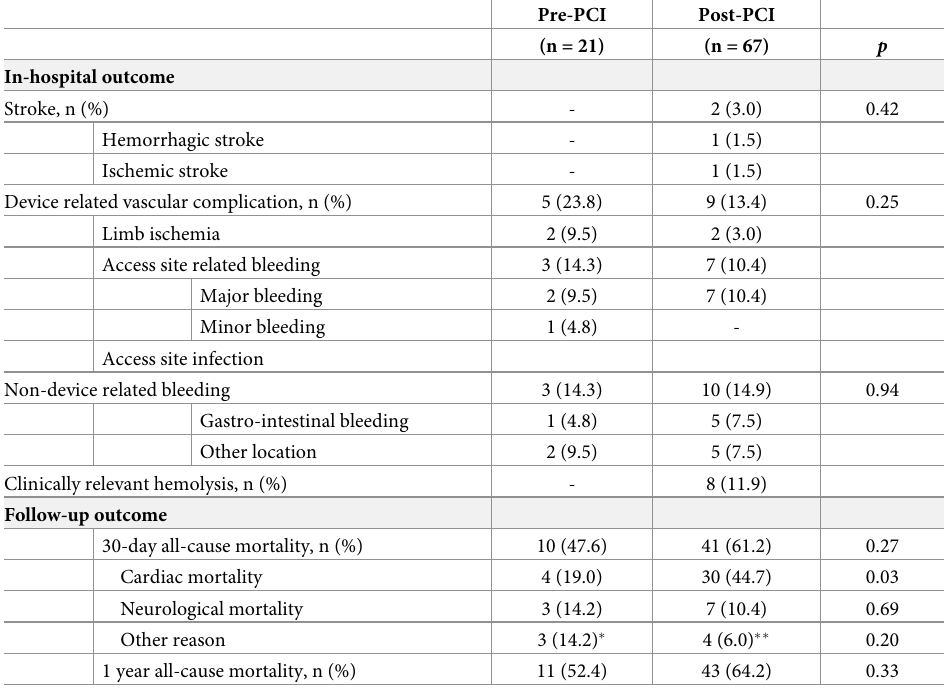
Table 3. Clinical outcome of AMICS patients treated with primary PCI and Impella.